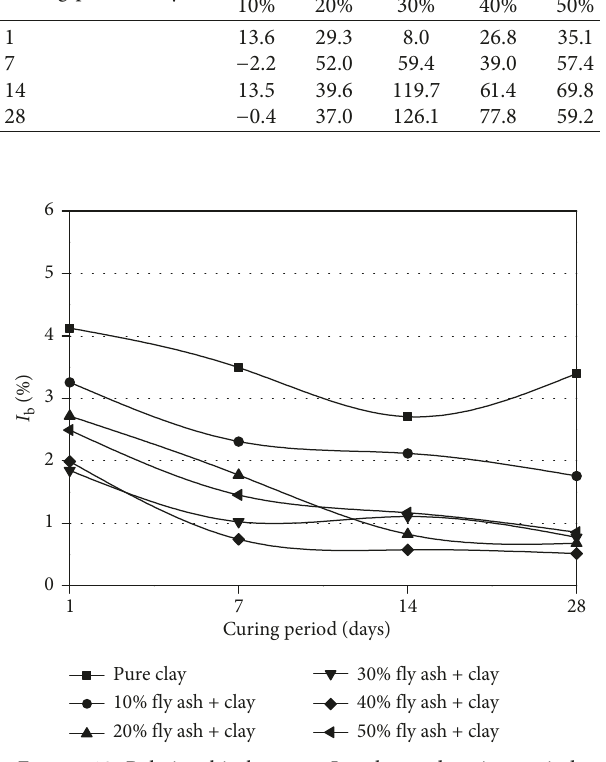
Figure 10: Relationship between I